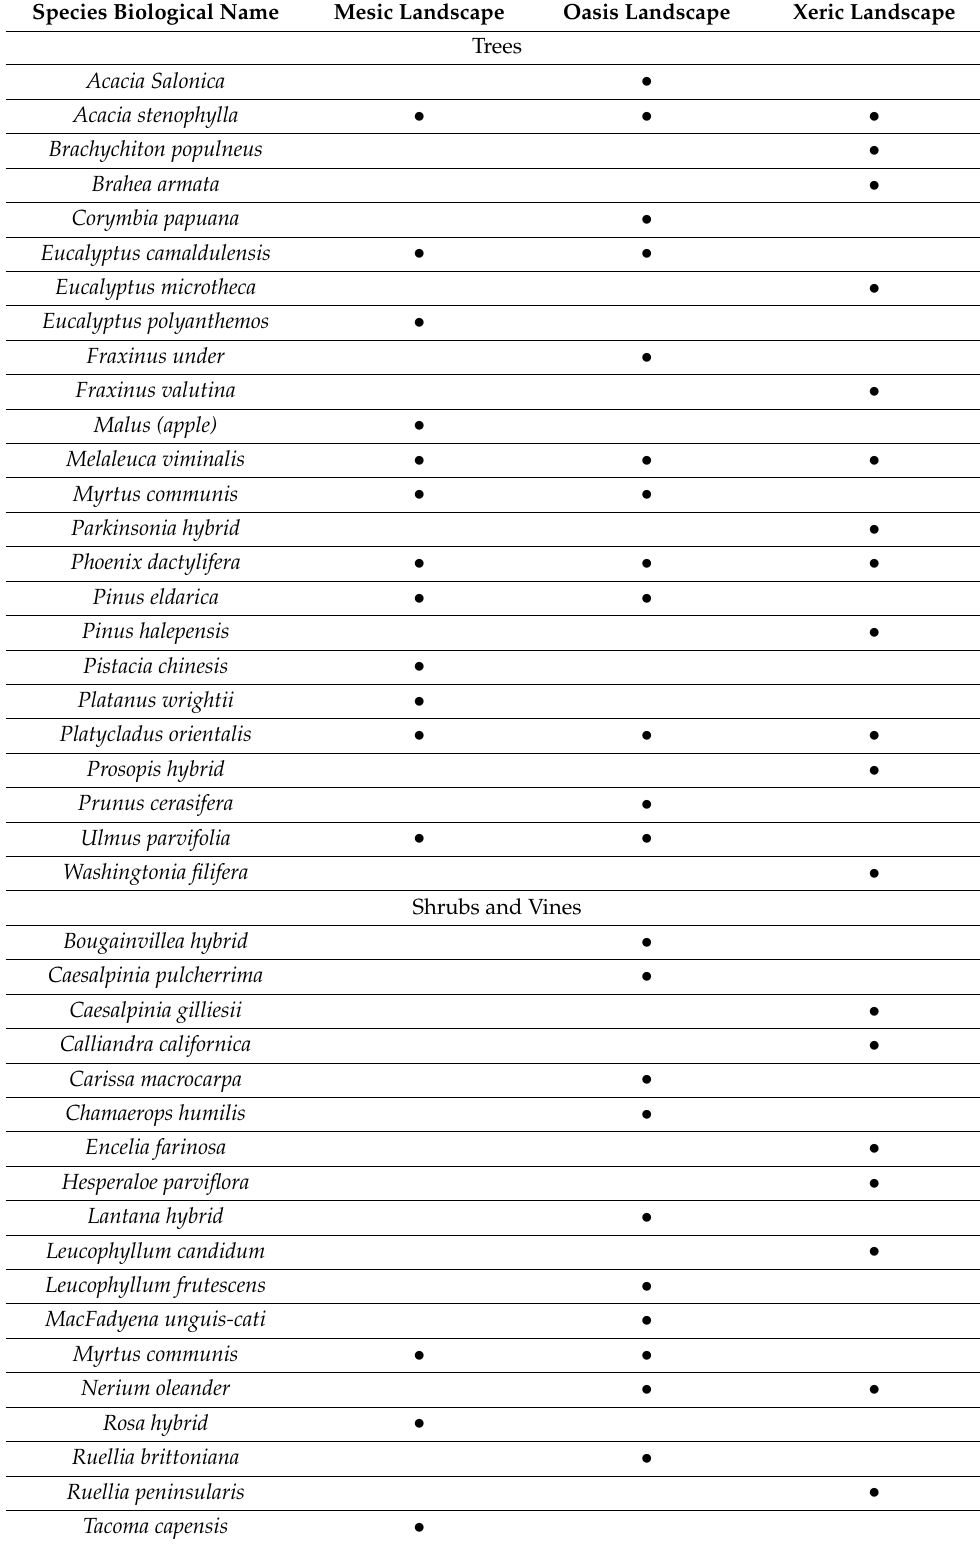
Table 1. Trees, shrubs, and vines in the study area were modeled using 2D plants in ENVI-met